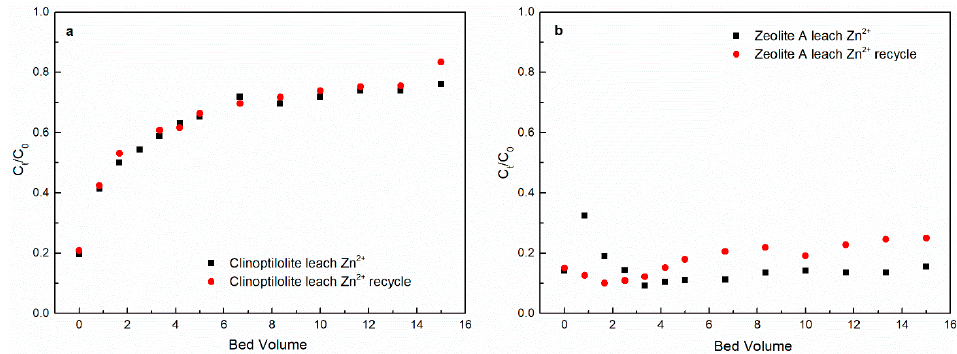
Figure 6. The breakthrough curves of the clinoptilolite ( a ) and zeolite A ( b ) leach Zn 2+ under 5 BV h − 1 ; the black data points represented pristine zeolites and the red data points stand for recycled zeolites.